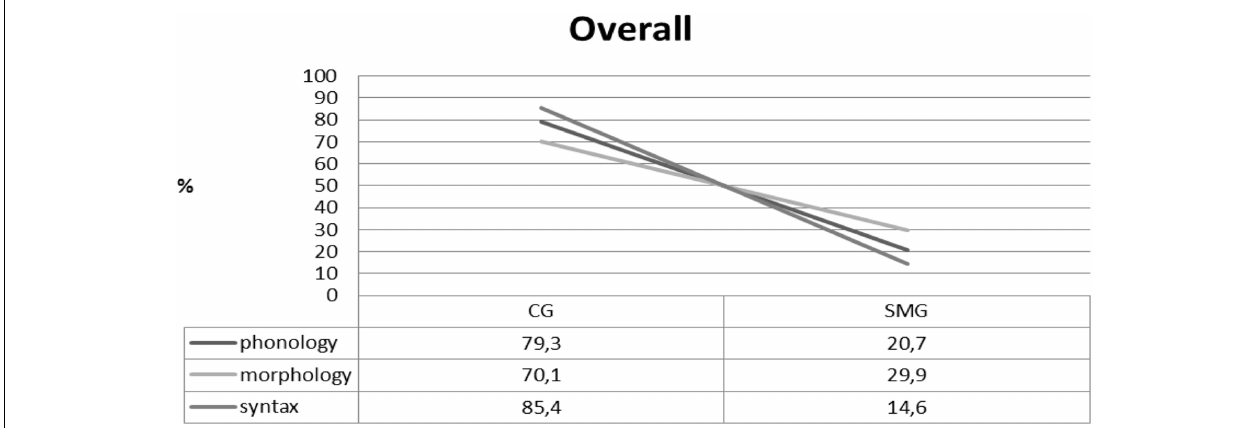
FIGURE 2 | Overall